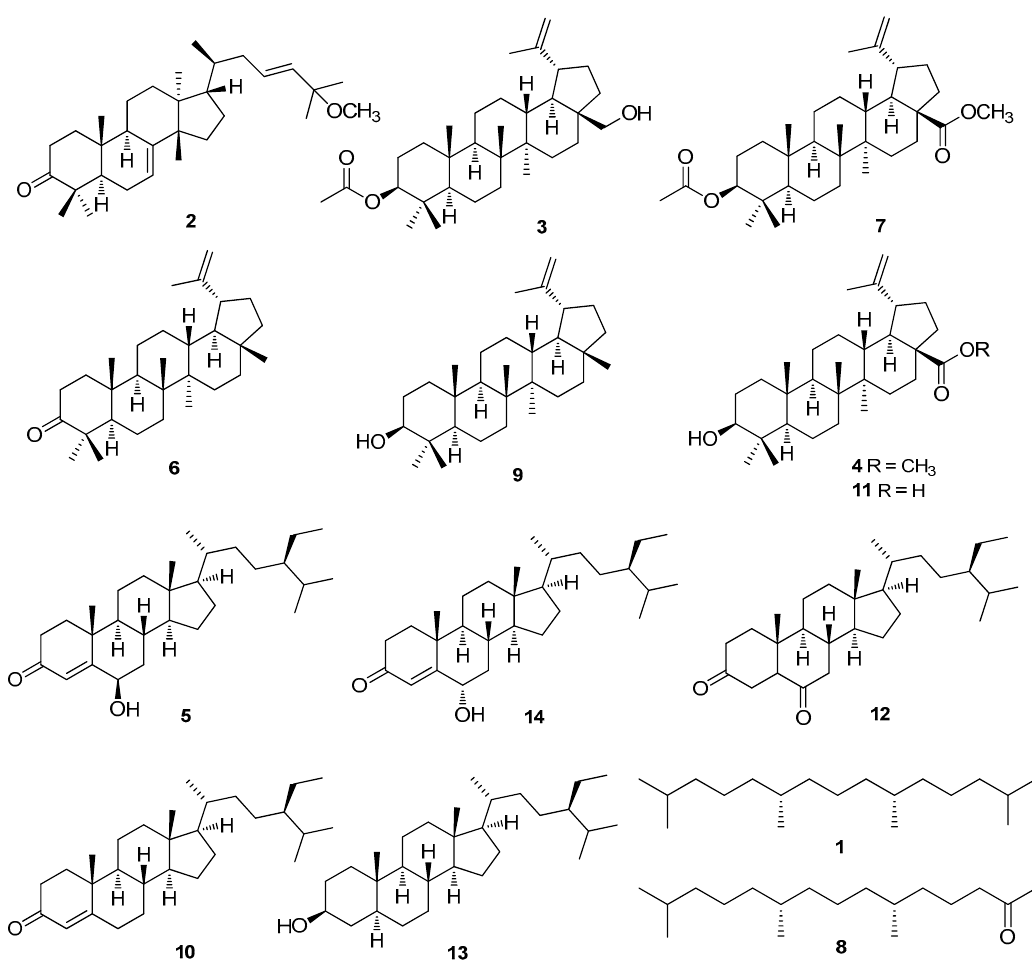
Figure 2. The chemical structures of compounds 1 – 14 .